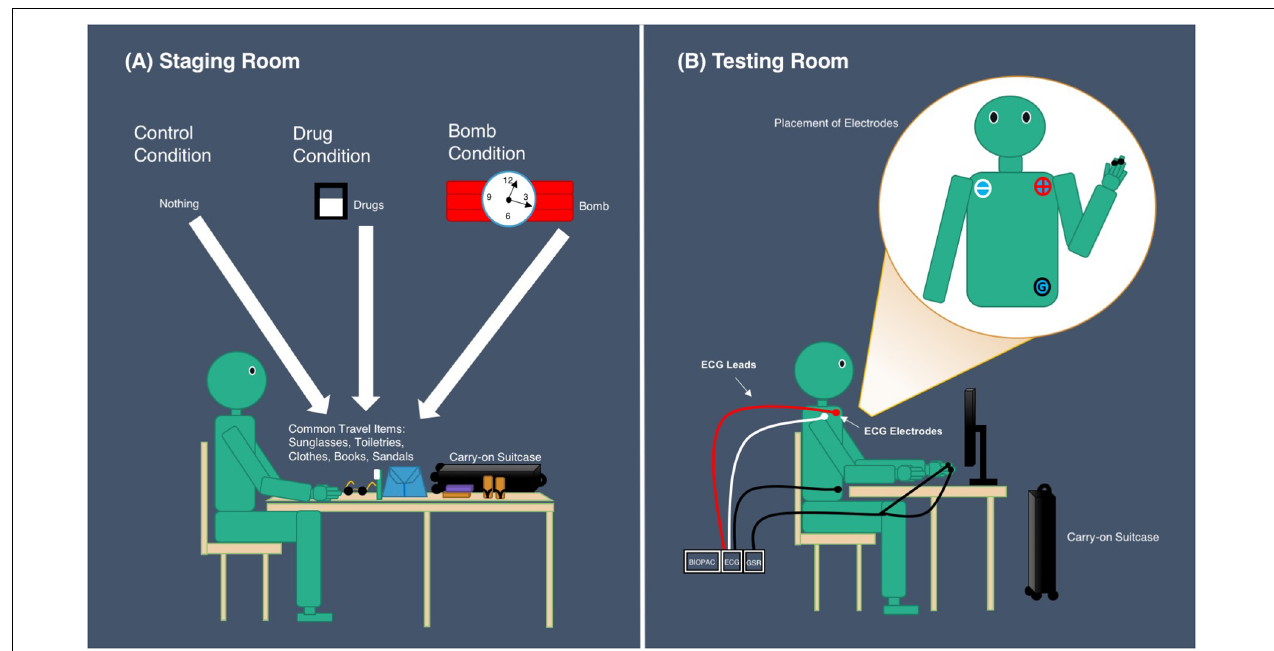
FIGURE 1 | (A) Set up of staging room. Note that the addition of the bomb condition only occurs in Experiment 2. (B) Set up of testing room.